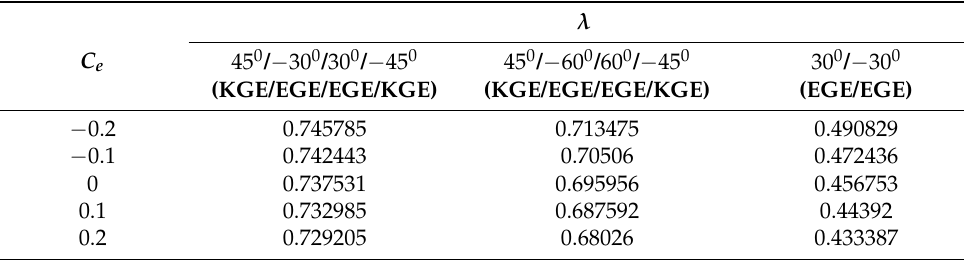
Table 3. Relation of exponential thickness variation C e and the fundamental frequency parameter λ .